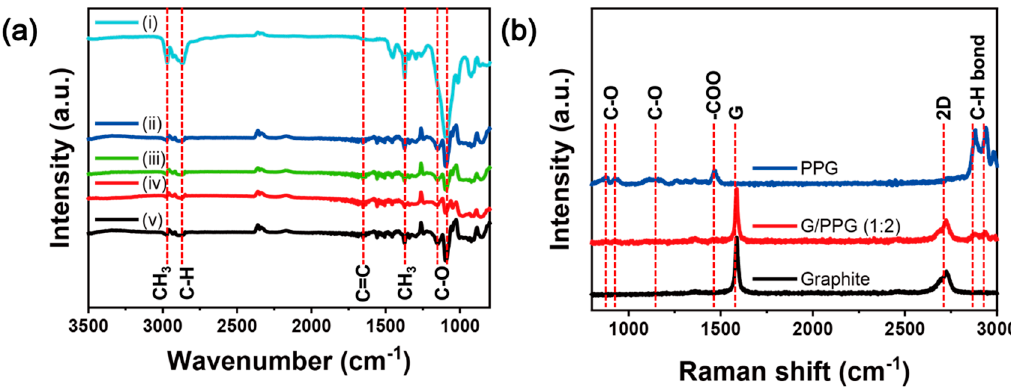
Figure 1. ( a ) FTIR of (i) pure PPG, (ii) G/PPG (1:2) hybrid composite (HC), (iii) G/PPG (1:1) HC, (iv) G/PPG (2:1) HC, and (v) pure graphite. ( b ) Raman spectra of pure PPG, G/PPG (1:2) HC, and pure graphite.